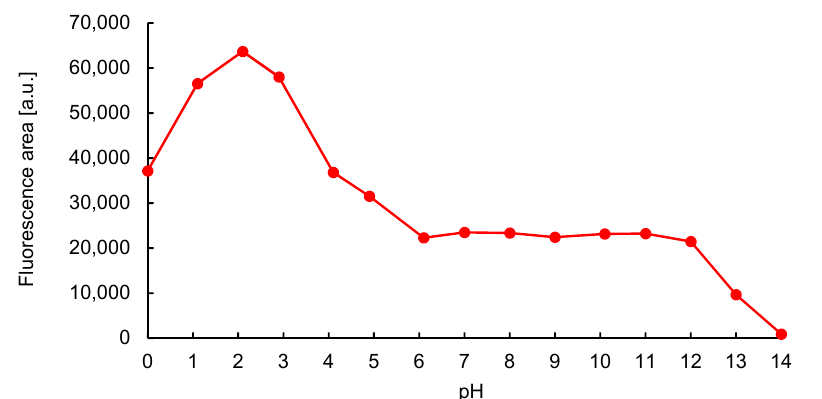
Figure 4. Graph of the relationship between fluorescence intensity of FM 17 and solution pH. Measured in H 2 O and excited at λ ex = 340 nm.